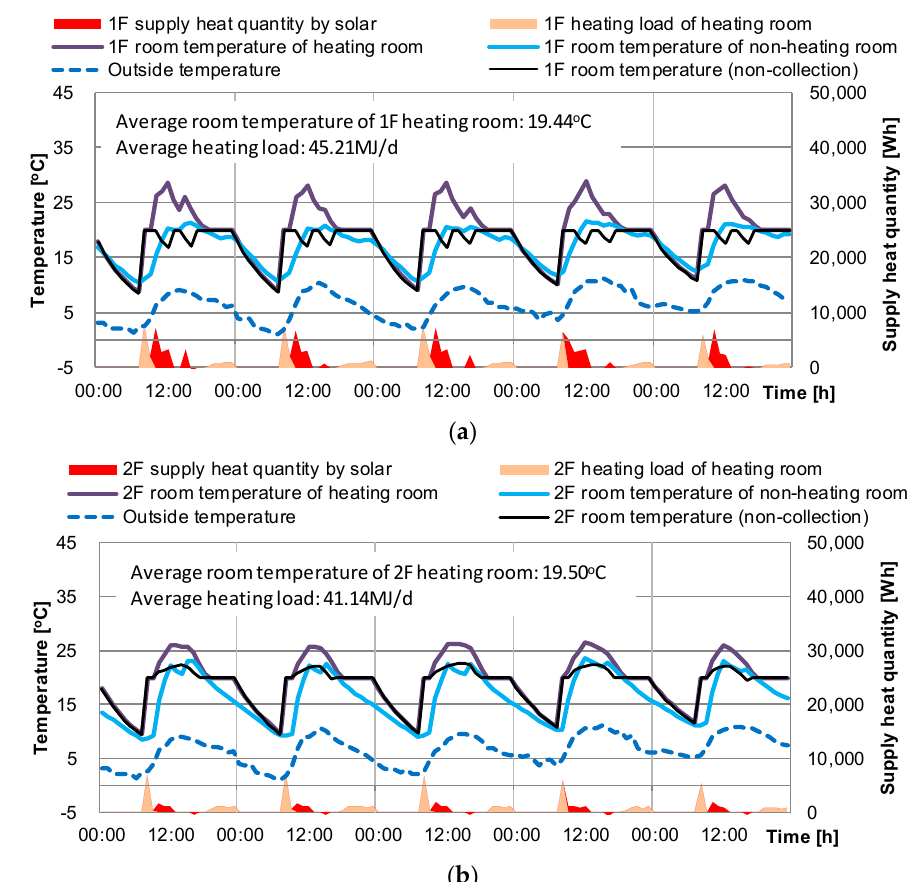
Figure 10. Conceptual diagram of the air-based solar heat collecting system.